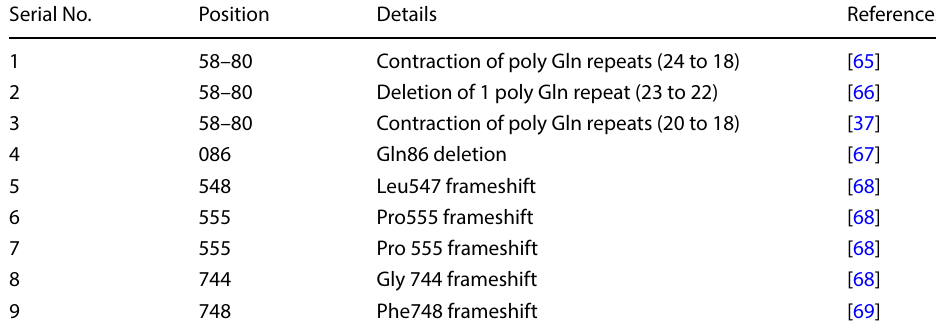
Serial No. Position